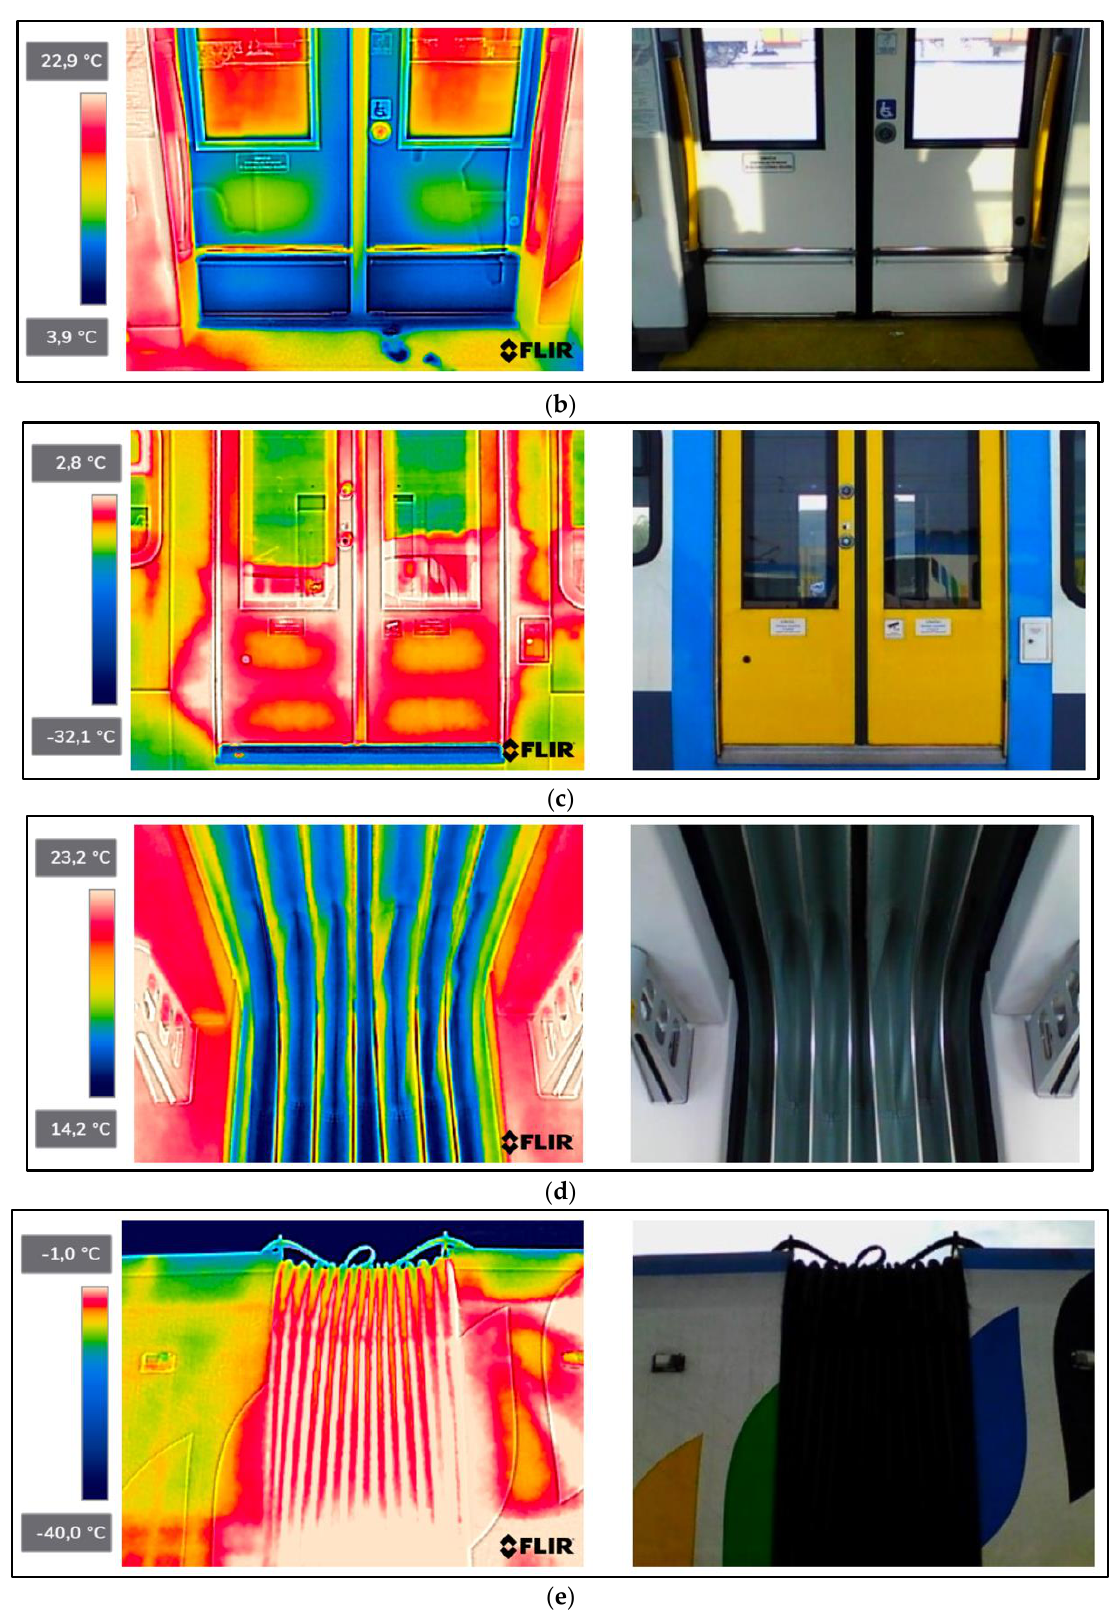
Figure 4. 27WEb-003 − thermogram of critical components of the railway vehicle: ( a ) door − upper part from inside the vehicle; ( b ) door − lower part from inside the vehicle; ( c ) door from outside the vehicle; ( d ) interconnection from inside the vehicle; ( e ) interconnection from outside the vehicle.